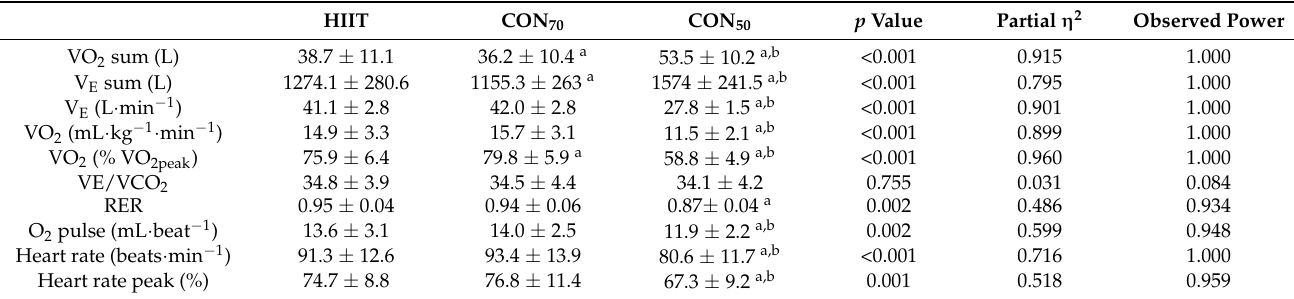
Table 2. Cardiorespiratory responses during HIIT, CON70 and